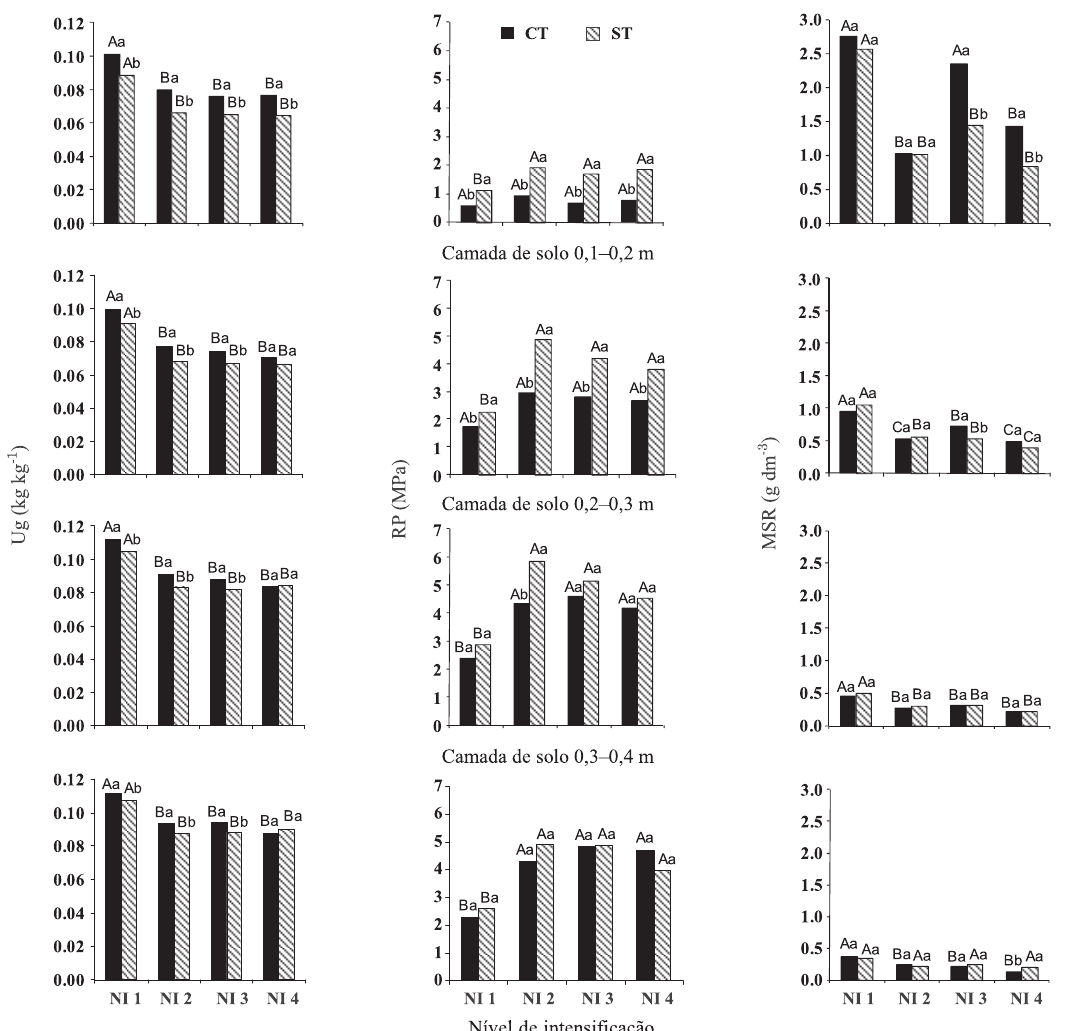
Figura 3. conteúdo de água no solo (ug), resistência do solo à penetração (RP) e massa seca de raízes (msR) em função do nível de intensificação do uso da pastagem (ni 1 , ni 2 , ni 3 e ni 4 ) e da posição de coleta das amostras (ct e st). letras maiúsculas comparam os níveis de intensificação (ni 1 , ni 2 , ni 3 e ni 4 ) na posição ct (colunas em preto) e na posição st (colunas com hachuras); letras minúsculas letras iguais não diferem pelo teste de scott-Knott (p <